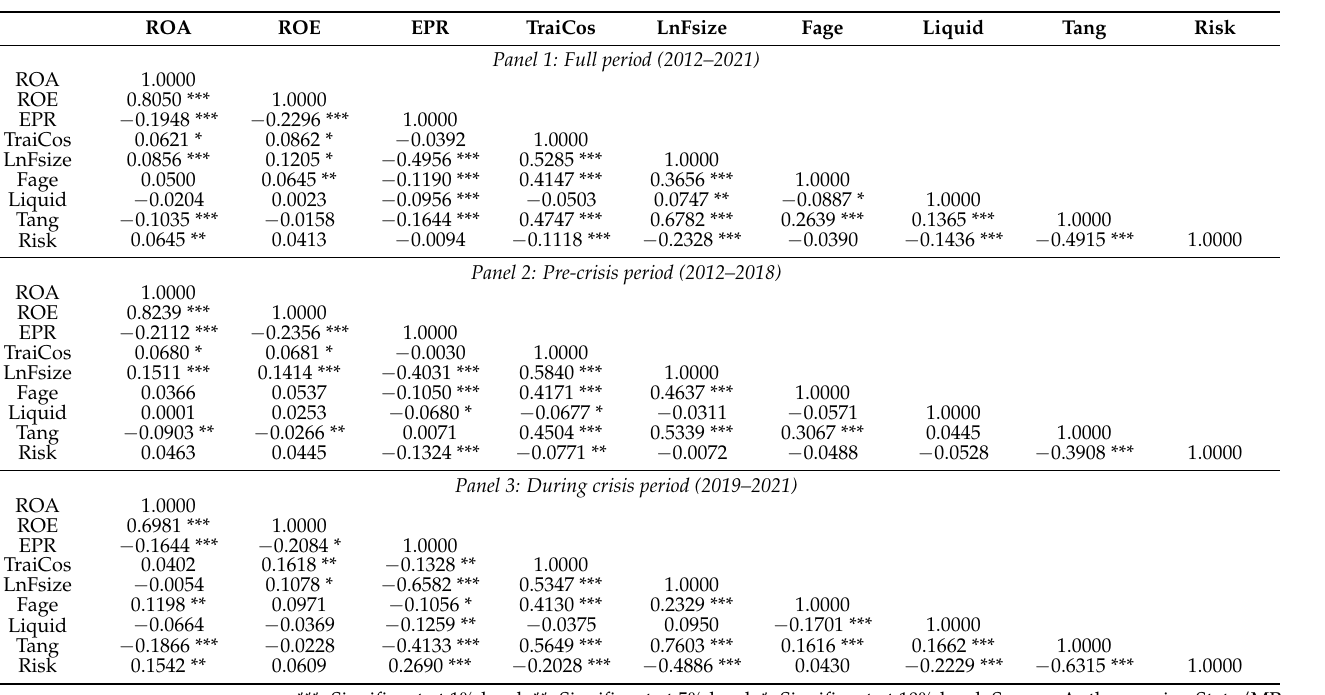
Table 2. Correlation